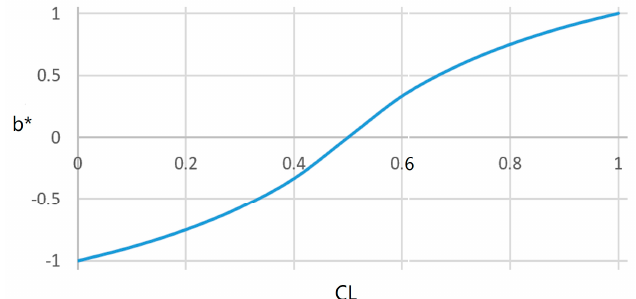
Figure 7. Relationship between degree of conformation b * and confidence level CL . As CL changes from 0 to 1, b * changes from − 1 to